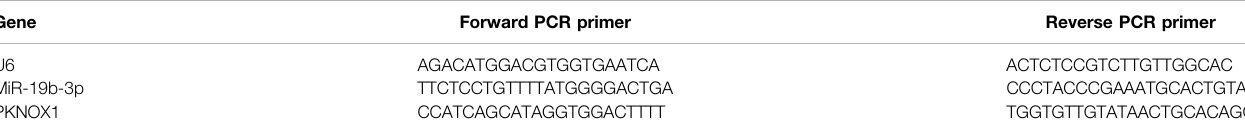
TABLE 1 | Sequences of primers used in PCR.